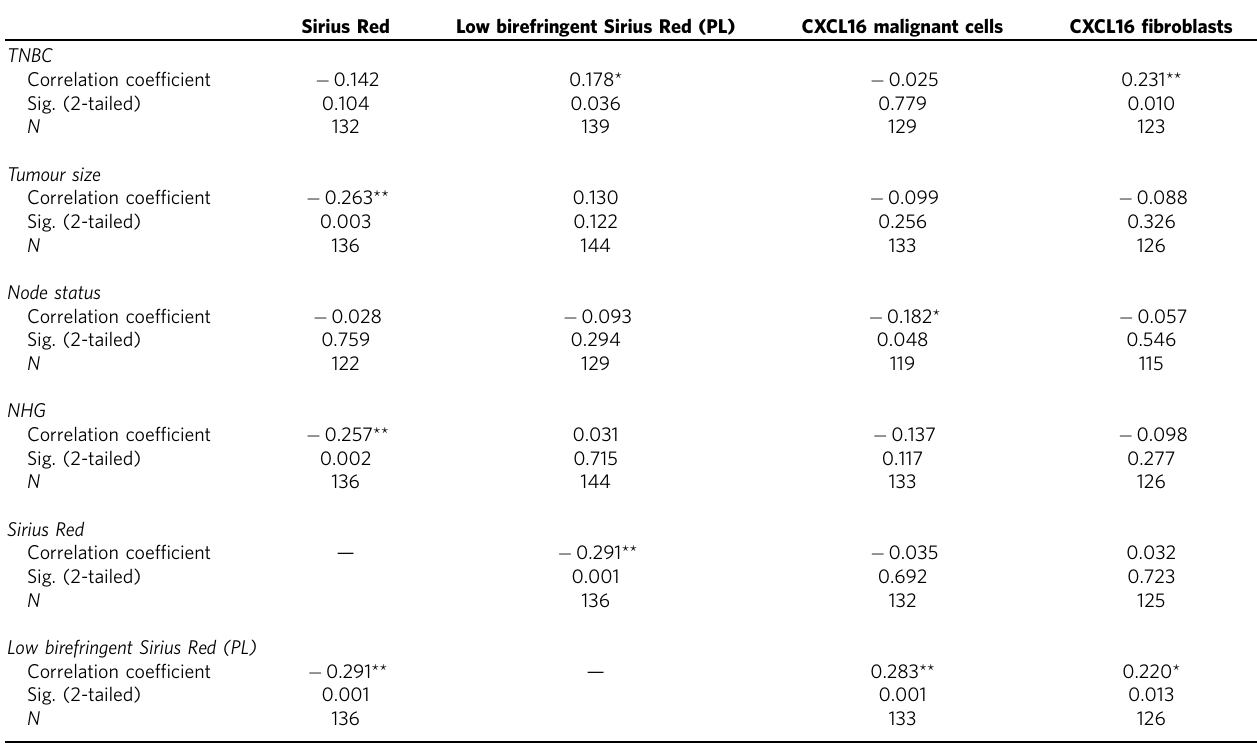
Table 1 | Analysis a of CXCL16 and Collagen expression in a breast cancer tissue